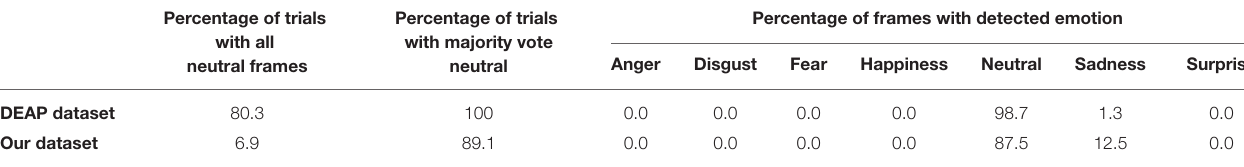
TABLE 4 | The result of using facial macro-expression model for detecting emotions from all frames. Percentage of frames with detected emotion Percentage of trials Percentage of trials with majority vote with all Anger Disgust Fear Happiness Neutral Sadness neutral neutral frames